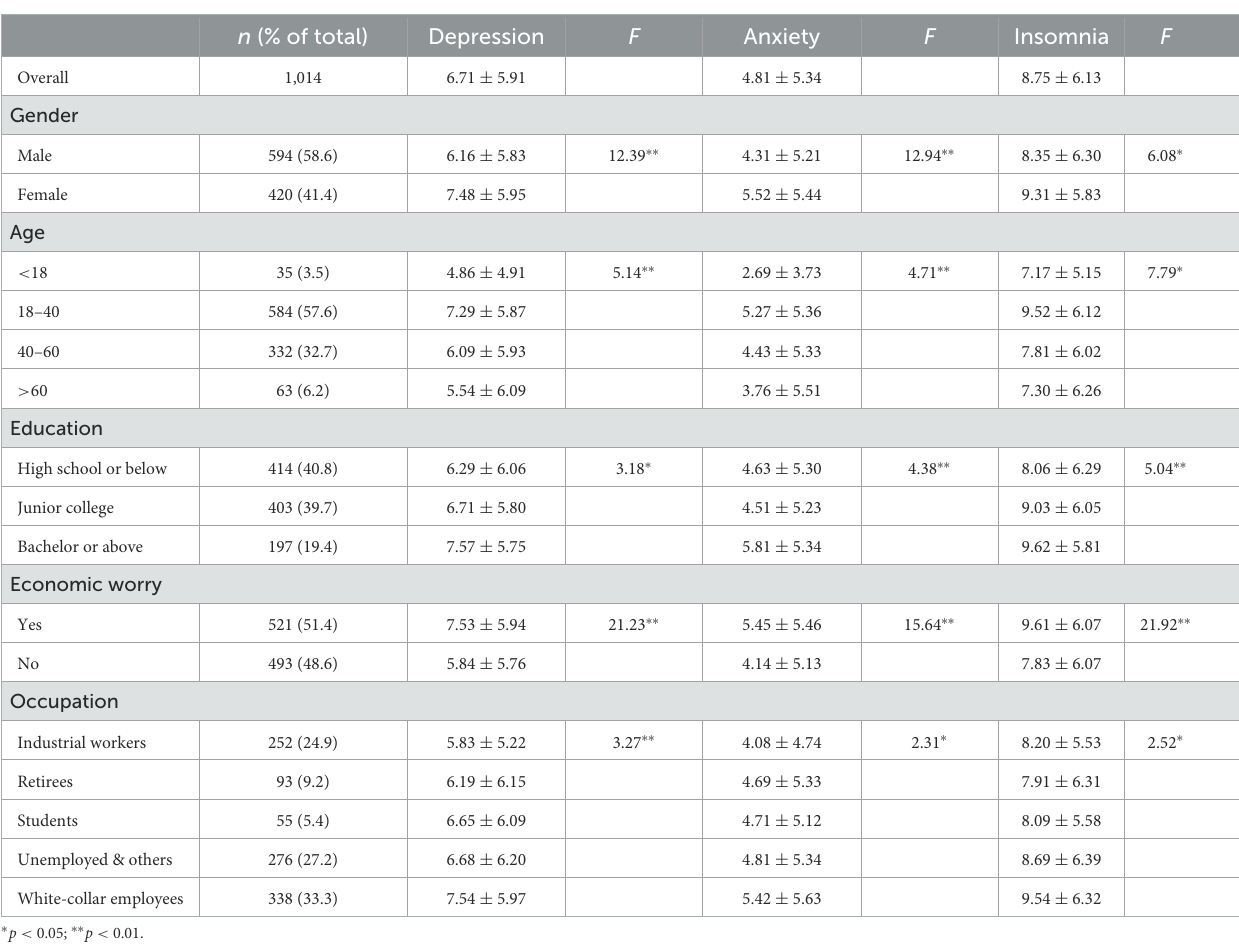
TABLE 1 Demographic characteristics of patients.